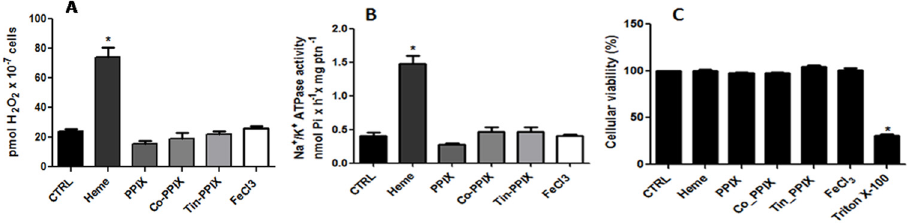
Fig 6. Effect of PPIX, Co-PPIX, Tin-PPIX and FeCl 3 on the production of hydrogen peroxide by L . amazonensis and in the Na + /K + ATPase activity of the parasite. Living parasites were incubated for 20 min in the reaction medium with the addition of 2.5 μ M PPIX, 2.5 μ M Co-PPIX, 2.5 μ M Tin-PPIX or 2.5 μ M FeCl 3 , as indicated on the abscissa. Hydrogen peroxide production (A), Na + /K + ATPase activity (B) and Cellular viability (C) were determinated. The values represent the mean ± standard error of at least three independent experiments. * Statistically significant when compared to control (P < 0.05). CTRL,